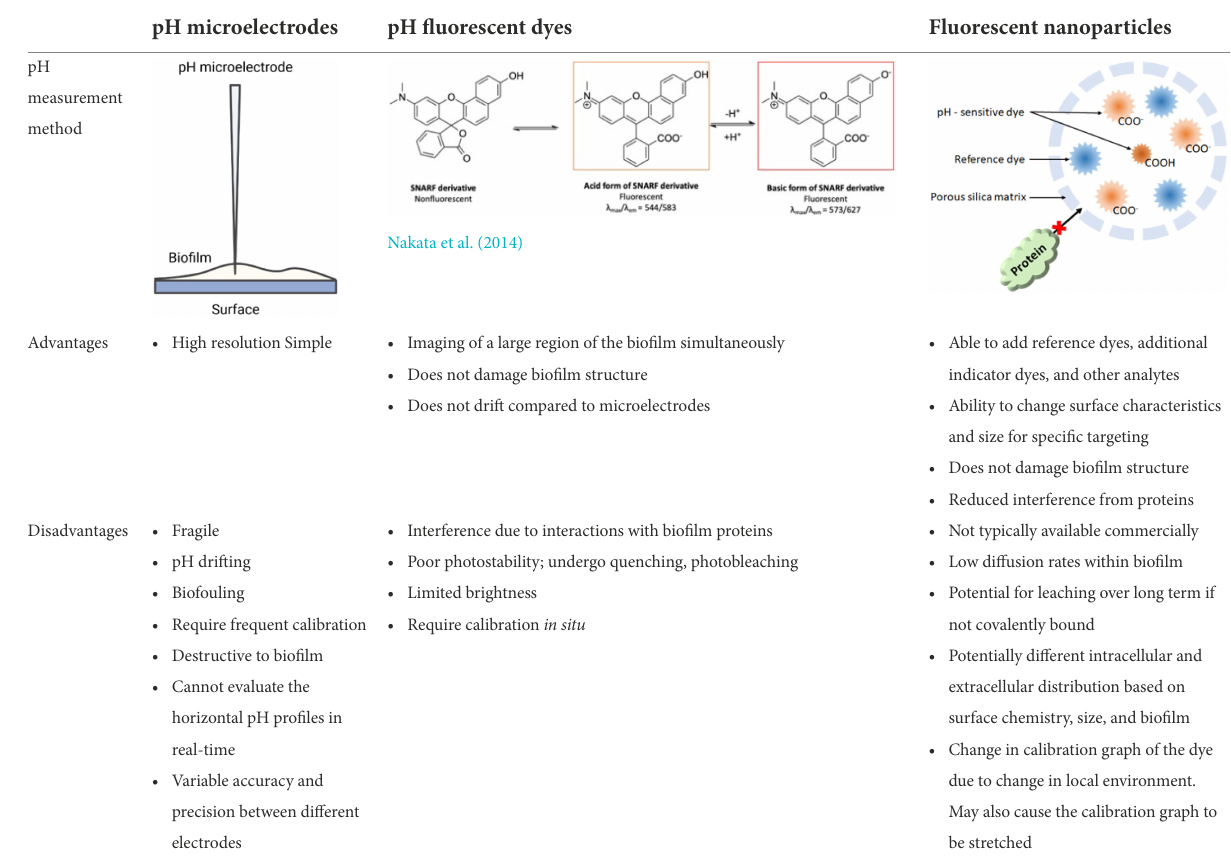
TABLE 1 Summary of the methods used to measure pH gradient in